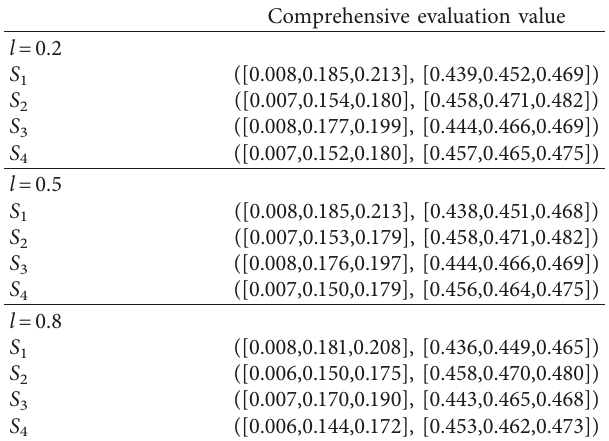
Table 6: The comprehensive evaluation value under the different l .